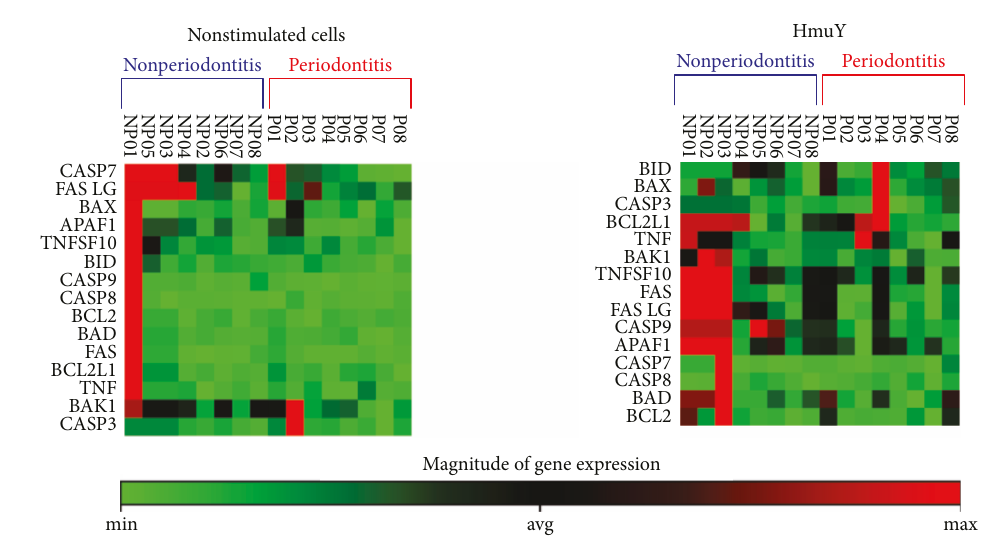
Figure 1: Gene cluster identi fi cation involved in apoptosis mechanisms by PBMC from individuals with periodontitis (P) and nonperiodontitis (NP) under P. gingivalis HmuY protein (HmuY) stimulus and in the absence of stimulus (nonstimulated cells). The green-black-red color gradient represents relative levels of gene expression, indicating under-even-over regulation,